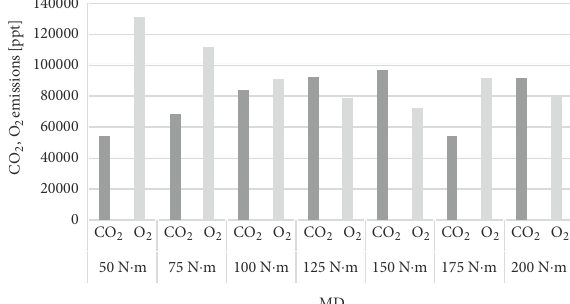
Figure 18. Emission of THC, NO x and CO for DRP sample with operating parameters of engine 3000 rpm